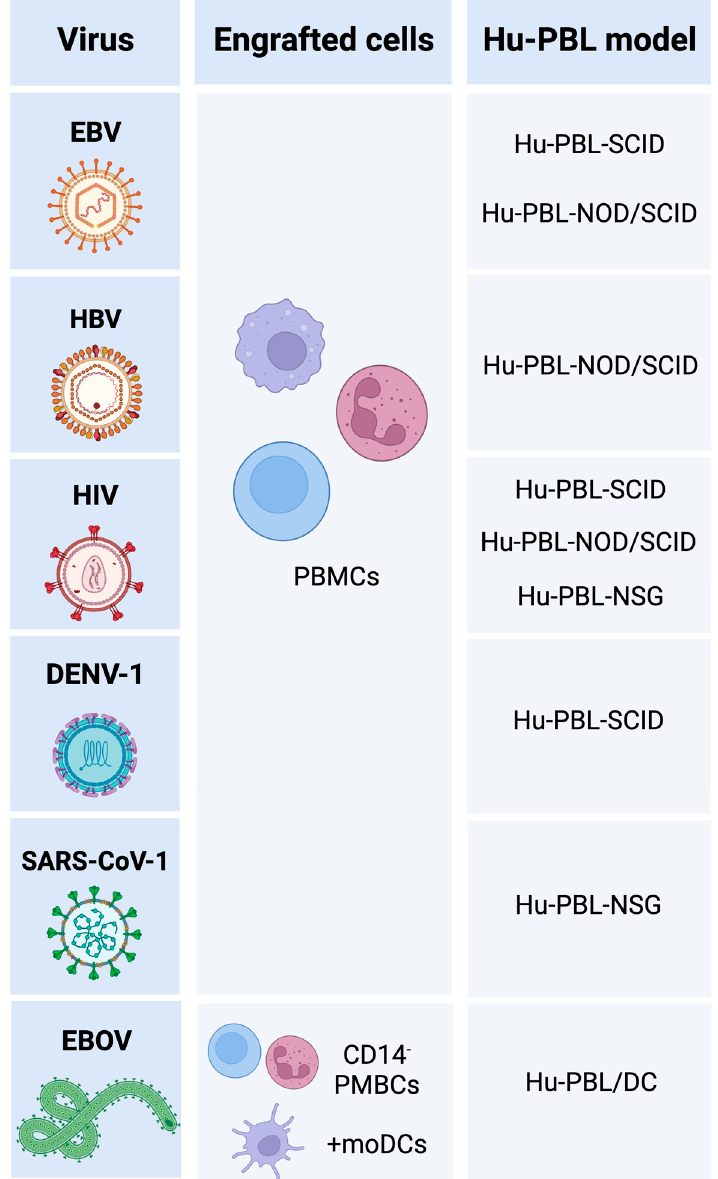
Figure 1. Hu-PBL mouse models used in research on the immunology of viral infections Figure 1. Hu-PBLmousemodelsusedinresearchontheimmunologyofviralinfections[8,22,24,37,38,43–83]. [8,22,24,37,38,43–83]. Created with BioRender.com. Created with